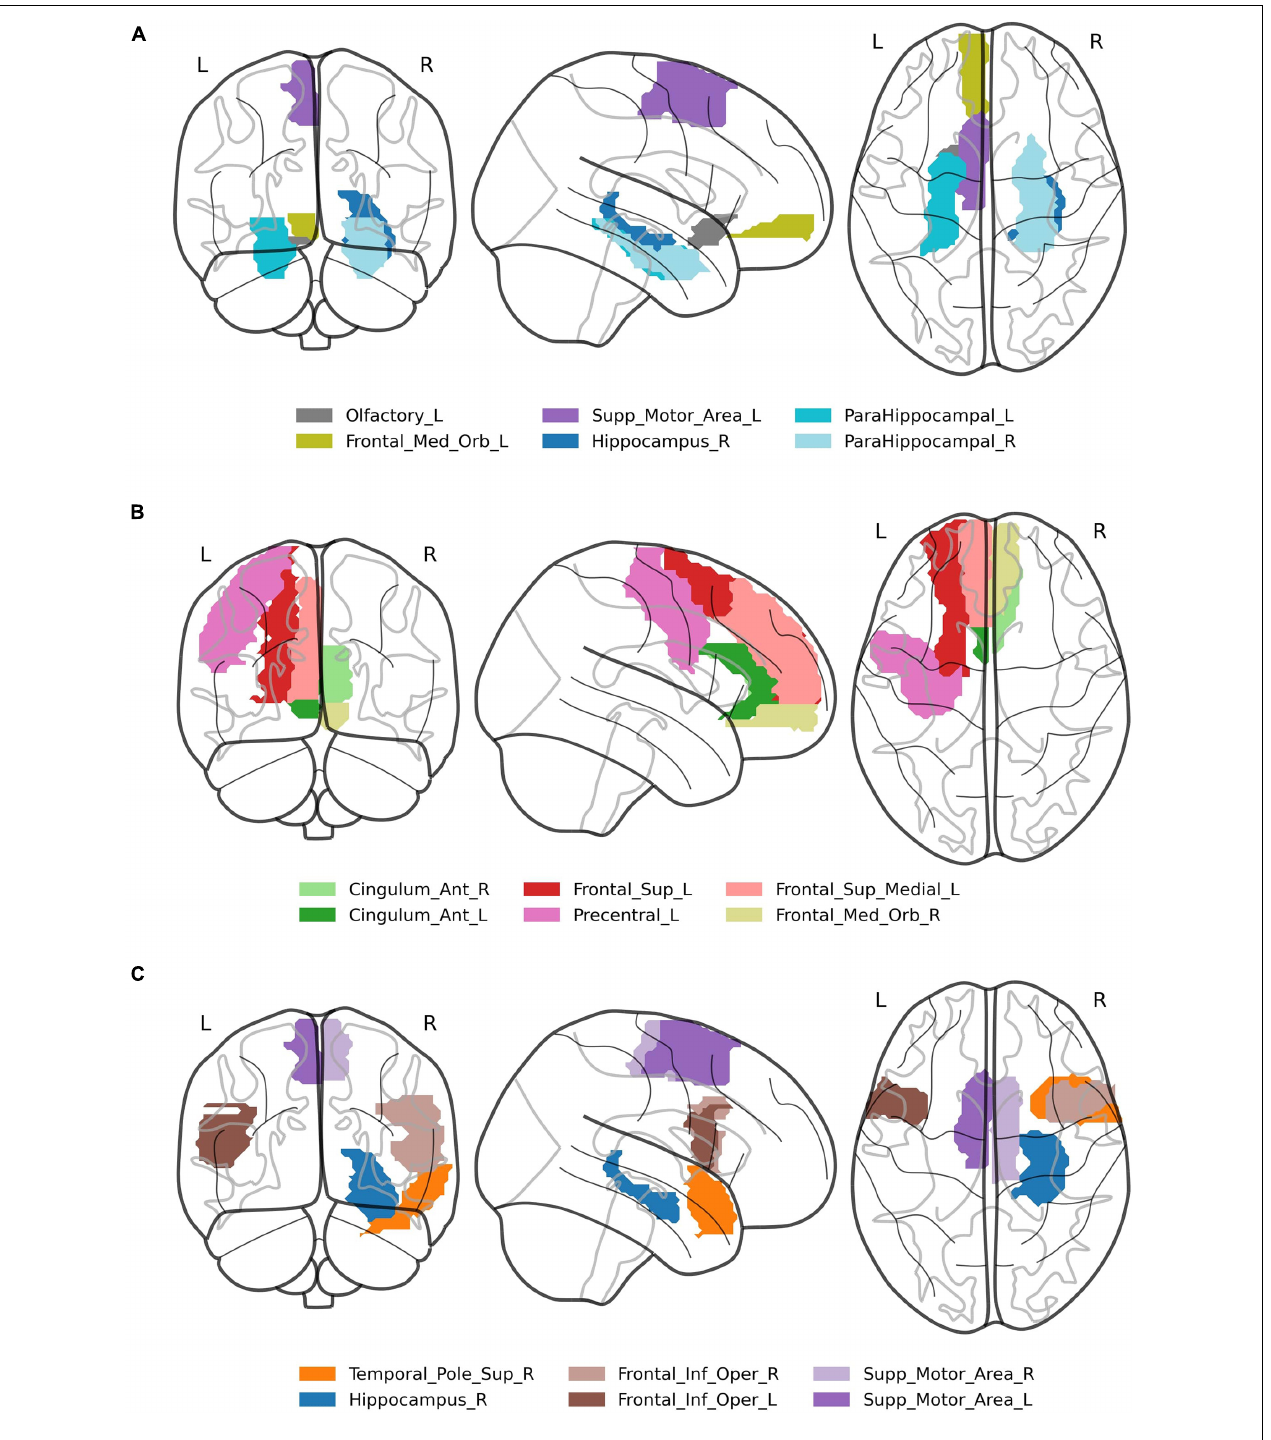
FIGURE 4 | Visualization of brain regions whose correlation with the stimuli predicts difference in response between lure and positive probes in: (A) global information processing task, (B) encoding in local information processing task, (C) retrieval in local information processing task.